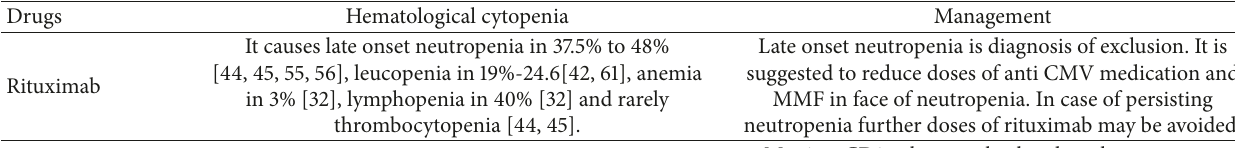
Table 1: Summary of drug-induced hematological